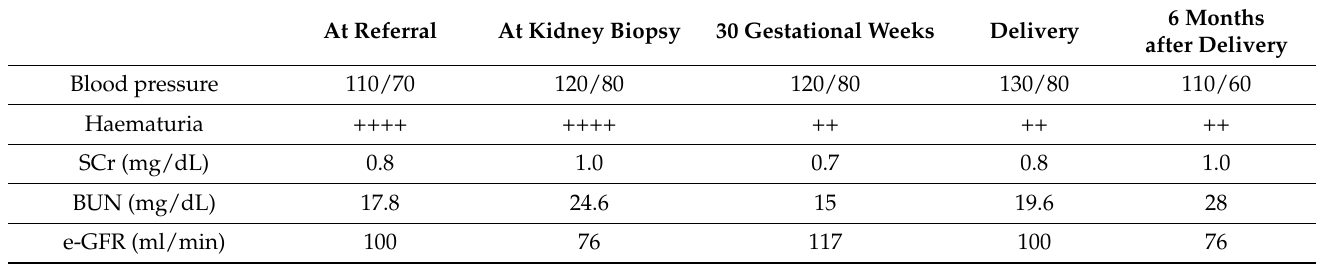
Table 1. Biochemical data from referral to delivery and after